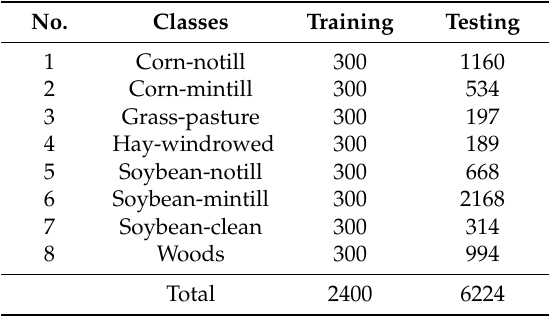
Table 2. Number of training and testing samples used in the Indian Pines dataset.